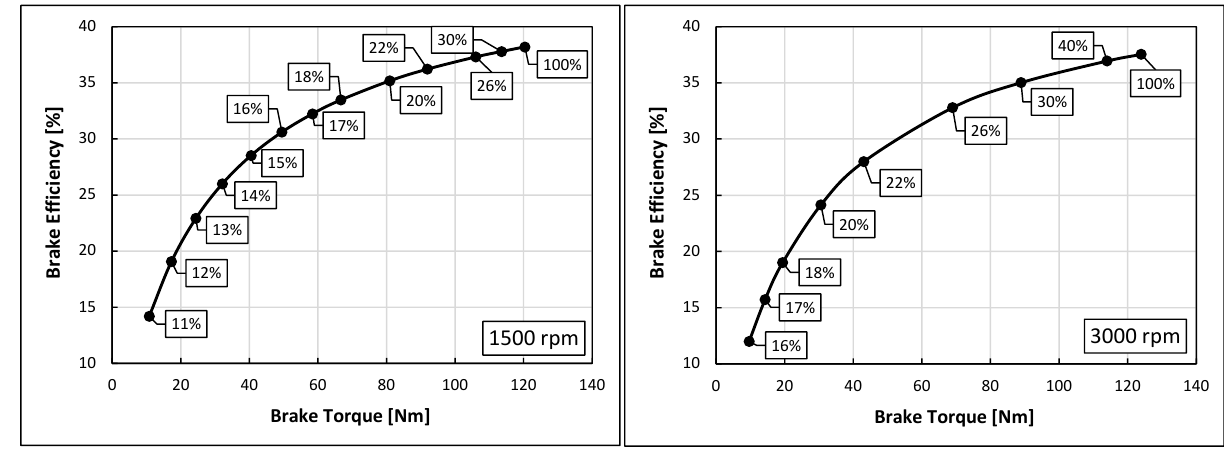
Figure 15. Brake efficiency as a function of the brake torque. The labels highlight the different throttle opening values. ϕ = 1, no boost.